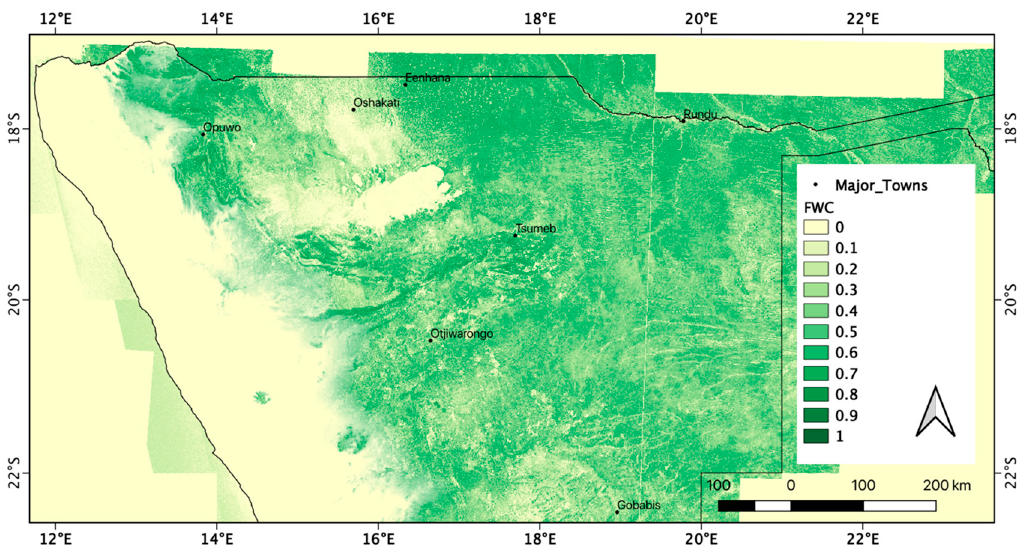
Figure 16. Fraction woody cover derived using only SAR variables (FWC2016 50mSAR ), with a mask applied over areas with MAP < 200 mm.